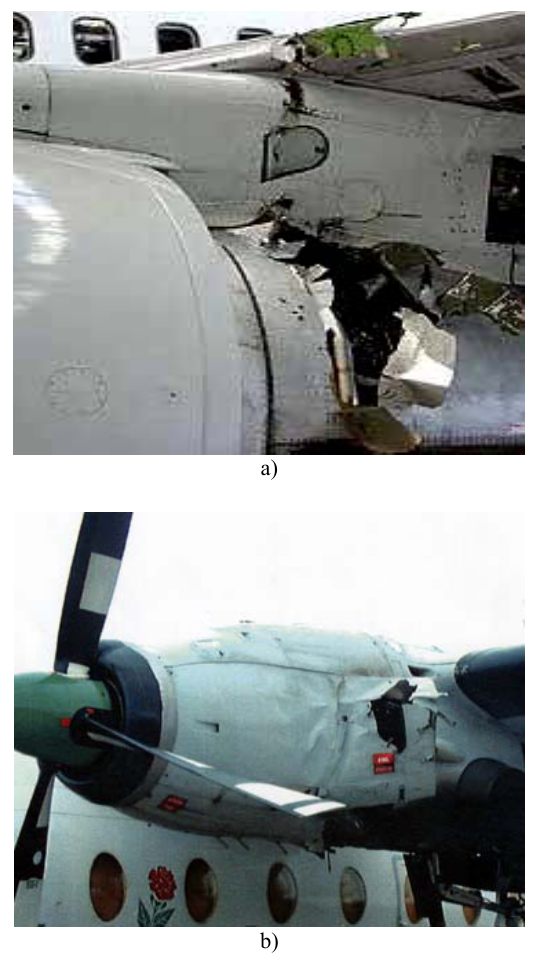
Fig 1. The engine casings punctured by disc fragments after catastrophic failure of